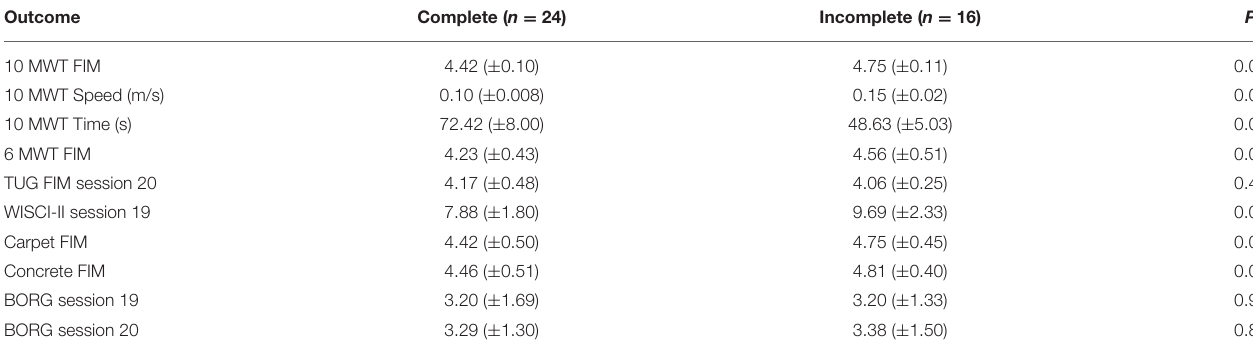
TABLE 7 | Stratification of outcome metrics according to the severity of spinal cord injury (complete vs. incomplete neurological injury). Outcome